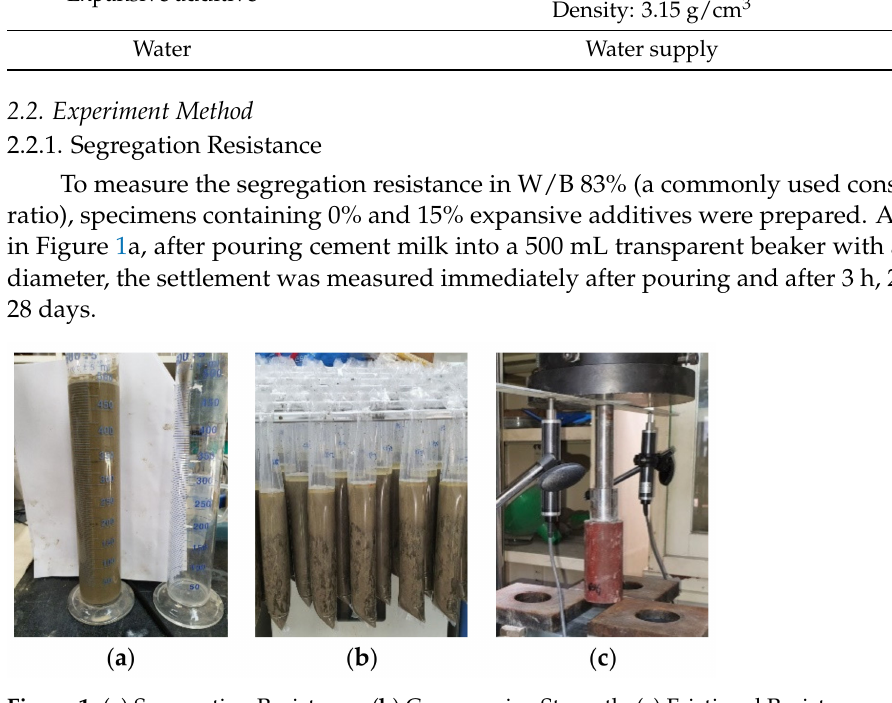
Figure 1. ( a ) Segregation Resistance; ( b ) Compressive Strength; ( c ) Frictional